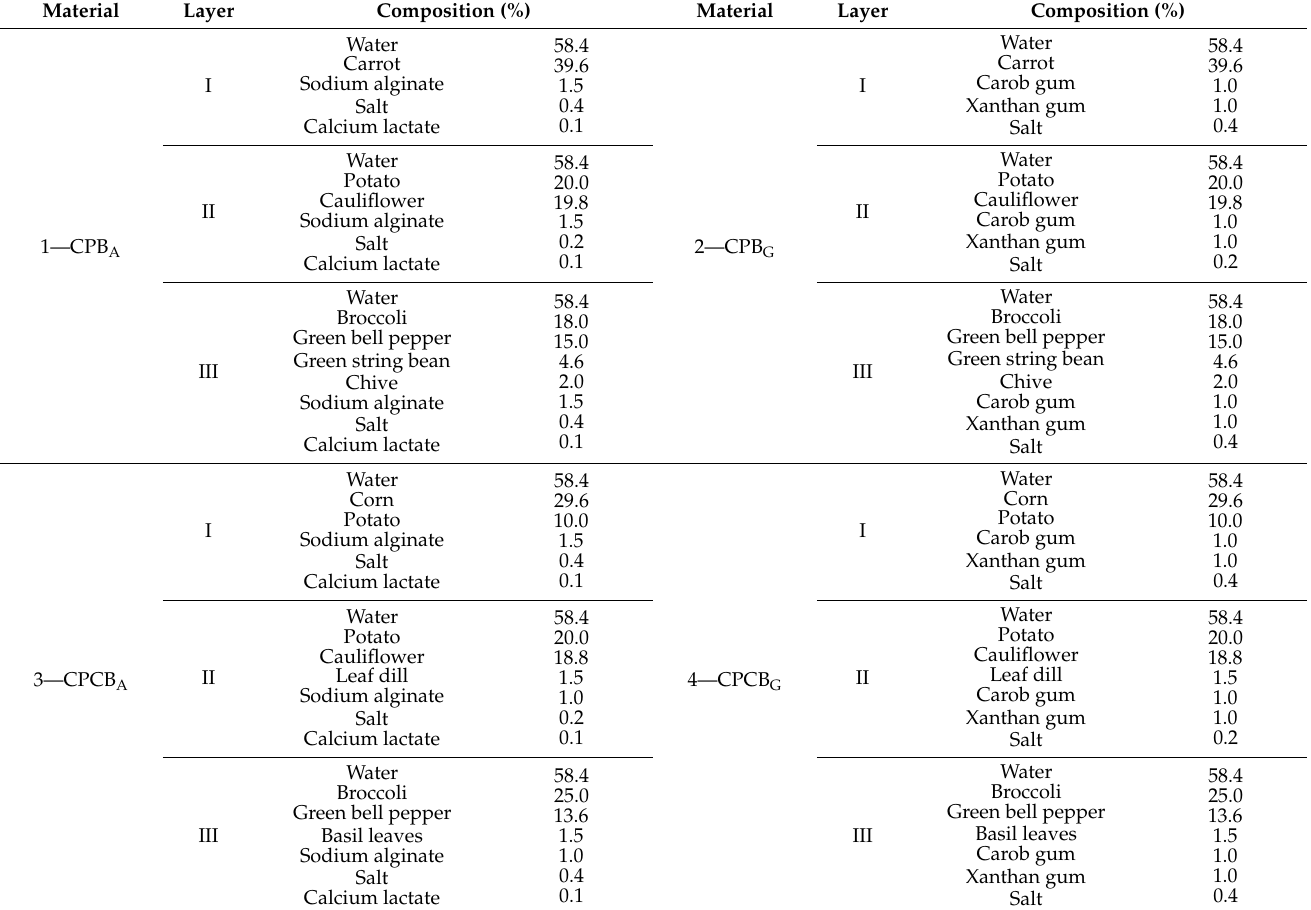
Table 1. Formulations of three-layer freeze-dried vegetable bars